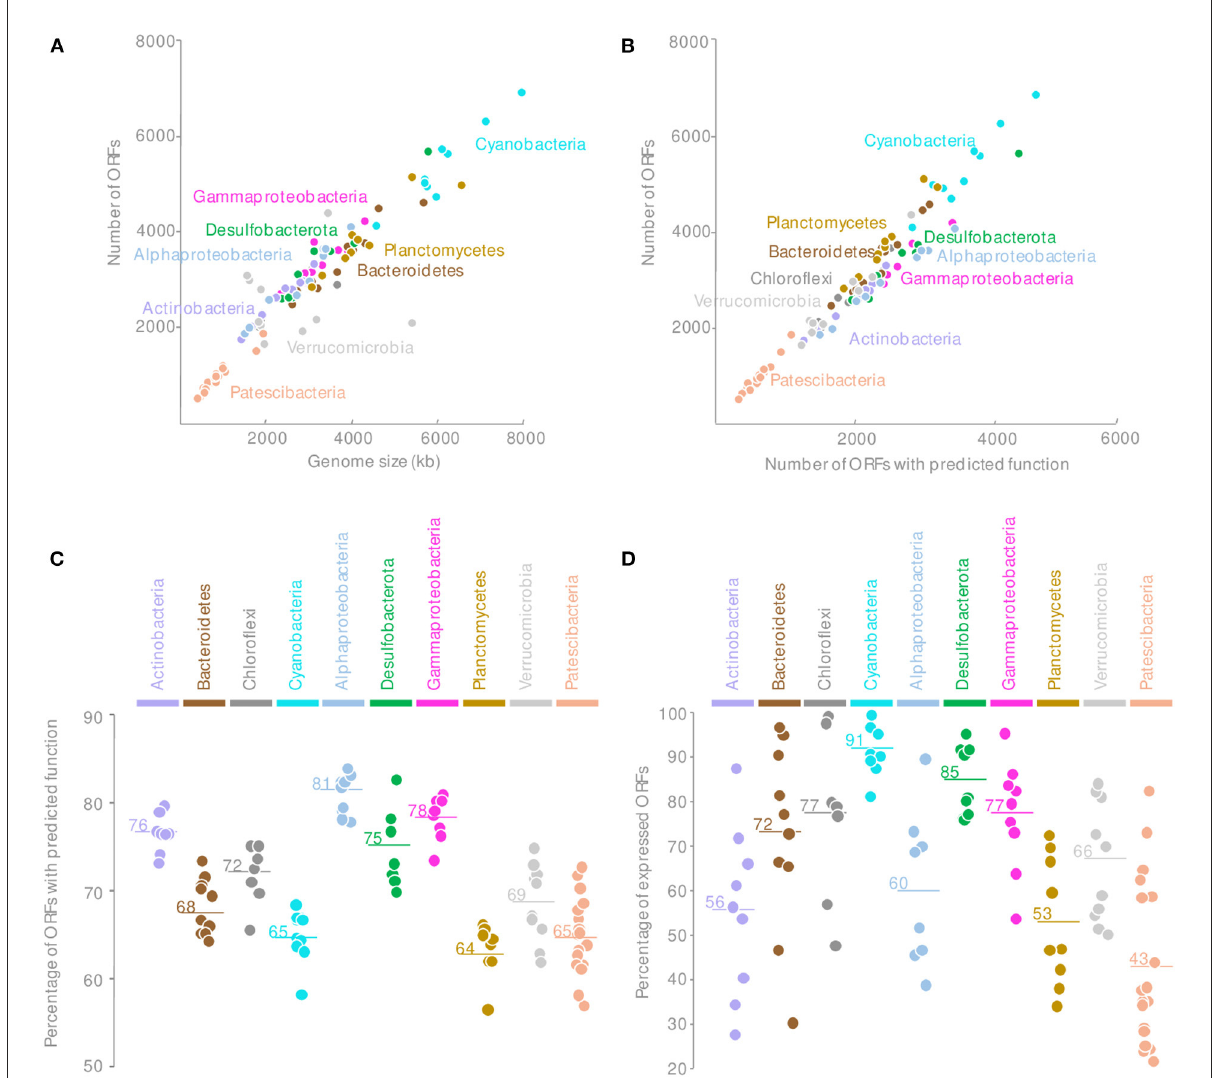
FIGURE2 Comparison of the MAGs genomic content of the Patescibacteria with other microbial phyla recovered from the microbial mats with (A) the number of ORFs by the estimated genome size, (B) the relationship between the total number of ORFs and the number of ORFs with predicted function; (C) the percentage of ORFs with predicted functions, and (D) the percentage of expressed ORFs for each major phyla of the microbial mats. Horizontal lines indicate the mean value.